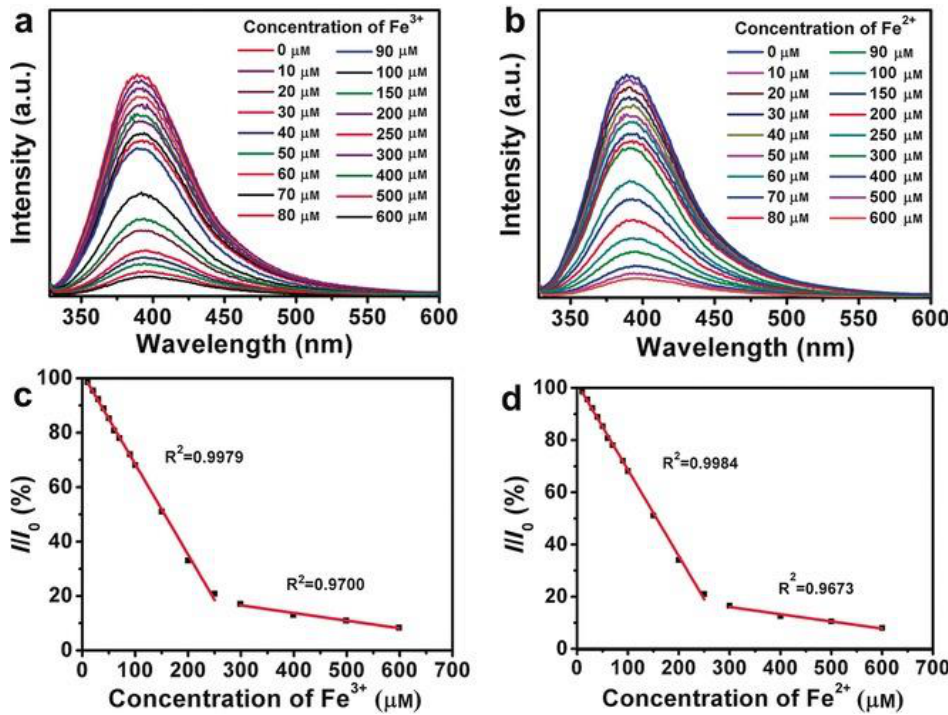
Figure 11. BNQDs-based sensing of ( a ) Fe 3+ and ( b ) Fe 2+ by measuring the PL intensity at λ ex = 310 nm, with ion concentrations of 10, 20, 30, 40, 50, 60, 70, 80, 90, 100, 150, 200, 250, 300, 400, 500, and 600 μm, and the linear relationship between the PL-quenching efficiency ( I / I 0 ) at λ ex = 310 nm and the concentration of ( c ) Fe 3+ and ( d ) Fe 2+ . Reproduced from [64] with permission